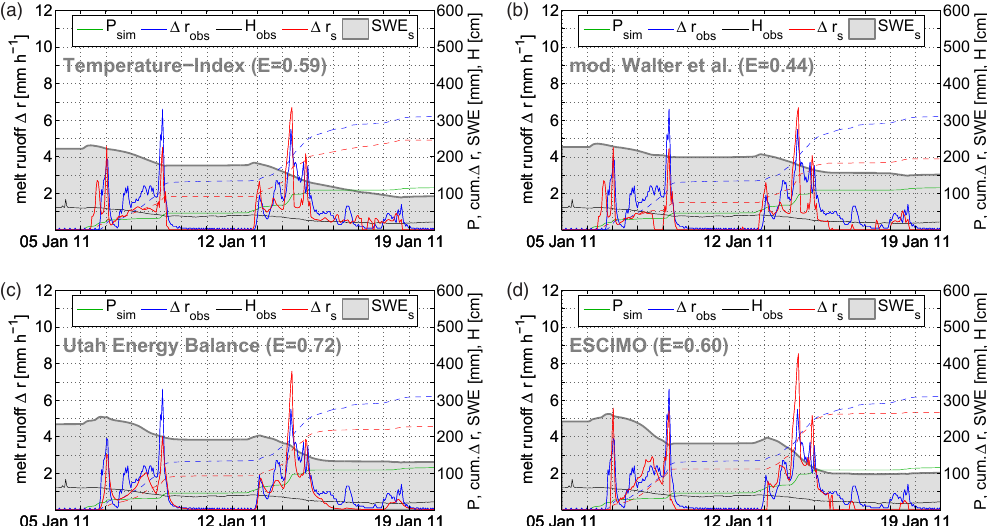
Figure 11. Snowmelt simulations at the point scale using downscaled meteorological time series for the winter season 2010–2011. Statistics refer to the period 5–20 January 2011: (a) temperature-index approach, (b) modified Walter et al. (2005) approach, (c) Utah Energy Balance model, and (d) ESCIMO. For every simulation run, downscaled precipitation depth ( P sim ), observed runoff ( (cid:49)r obs , blue line), observed runoff depth (blue dashed line), observed snow depth ( H obs ), simulated runoff ( (cid:49)r s , red line), simulated runoff depth (red dashed line), and simulated snow water equivalent (SWE s ) are plotted. Model efficiencies E are also given for each